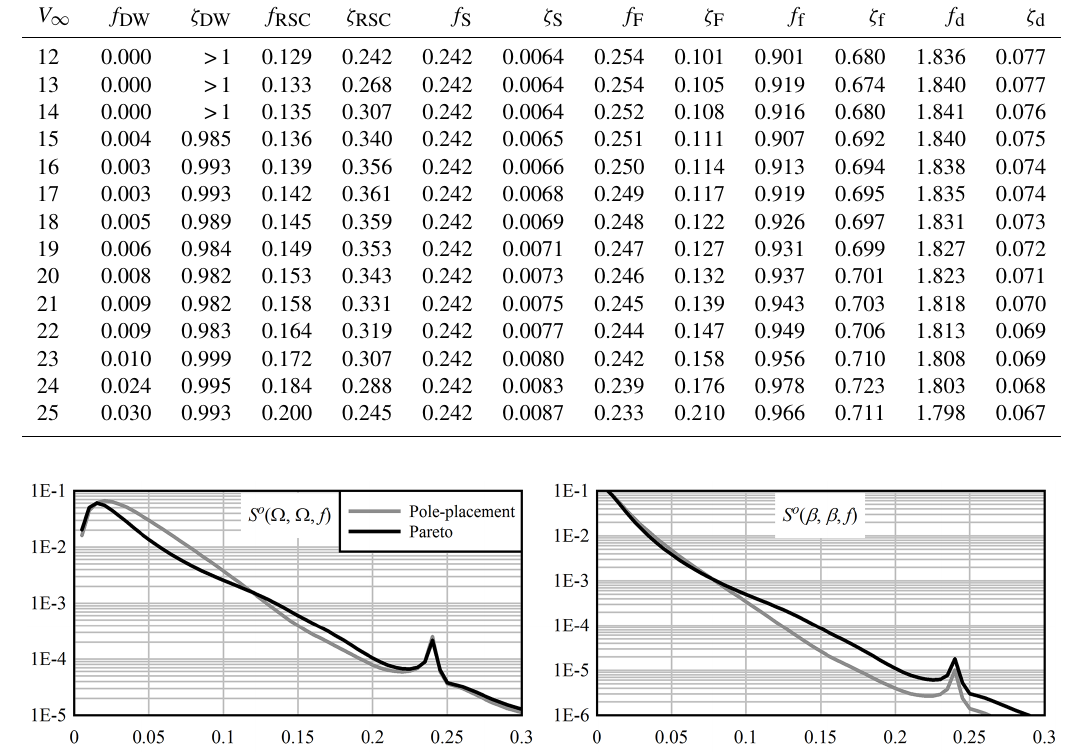
Table 6. Modal frequency and damping properties of the selected Pareto tuning. For abbreviations, including subscripts, please see the table in Appendix A.